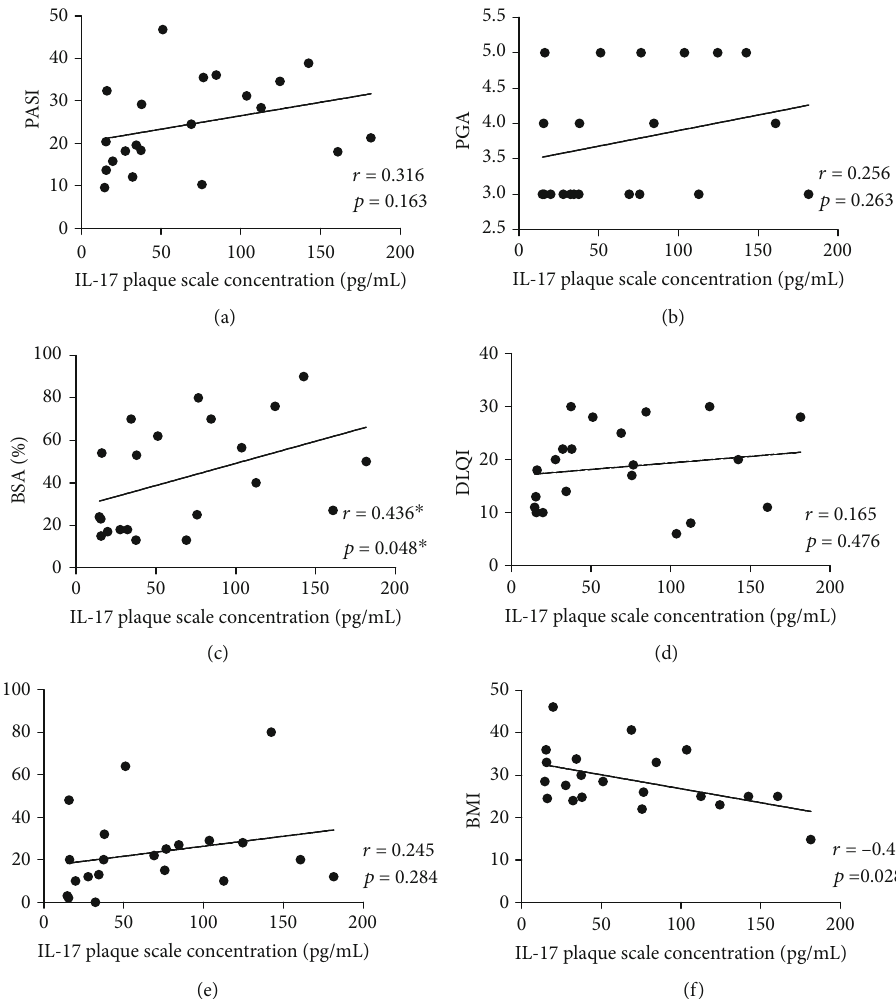
Figure 2: ThecorrelationbetweenIL-17plaquescale concentrationandclinicalfeaturesanddisease severityinpsoriatic patients; ∗ statistically signi fi cant